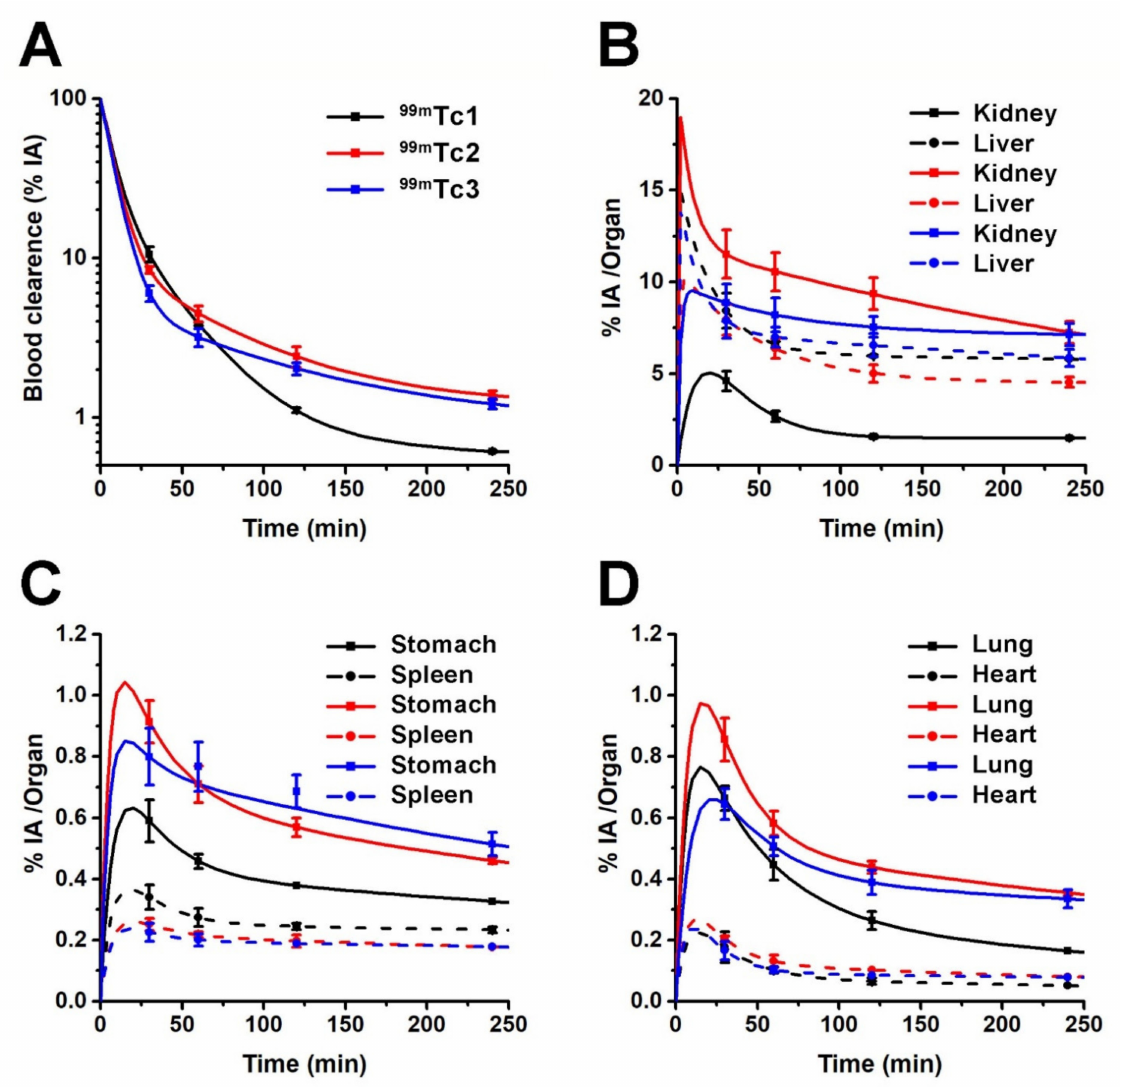
Figure 6. Time–activity curves in the main source organs: squares and circles show experimental data obtained from biodistribution studies after injection of 0.37 MBq of: 99m Tc1 (black), 99m Tc2 (red), and 99m Tc3 (blue), respectively. The four individual graphs represent: ( A ) blood, ( B ) kidney and liver, ( C ) stomach and spleen, and ( D ) lung and heart. The lines depict the calculated time–activity curves. Table 4. Mean resident time (MRT) of 99m Tc1–3 complexes in the main organs. MRT (min) Organ 99m